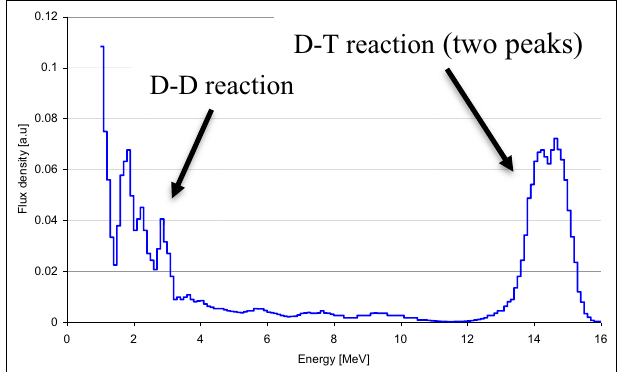
Figure 8. Neutron spectra of the Research Center Rez neutron generator